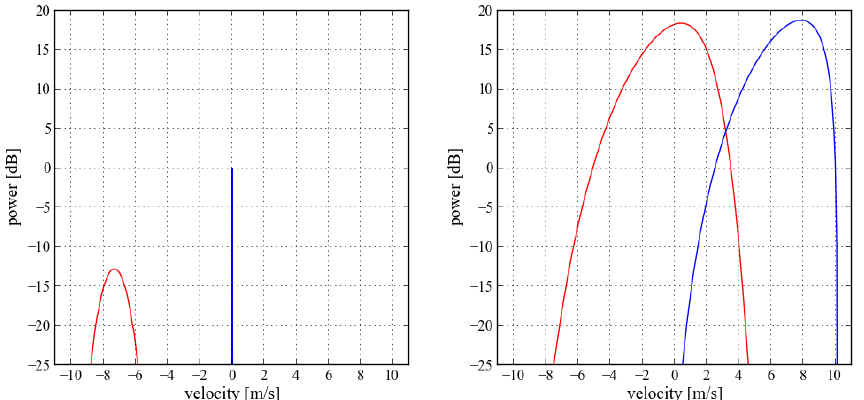
Figure 2. Original (blue) and aircraft-affected (red) Doppler spectra for monodisperse cloud (left) and typical rain particle distribution (right). Aircraft speed is 210 m s − 1 and pitch angle 2 ◦ . Marshall– Palmer size distribution with rain rate of 5 mm h − 1 is assumed. is adjusted by viewing the ambient target every 60 s. By